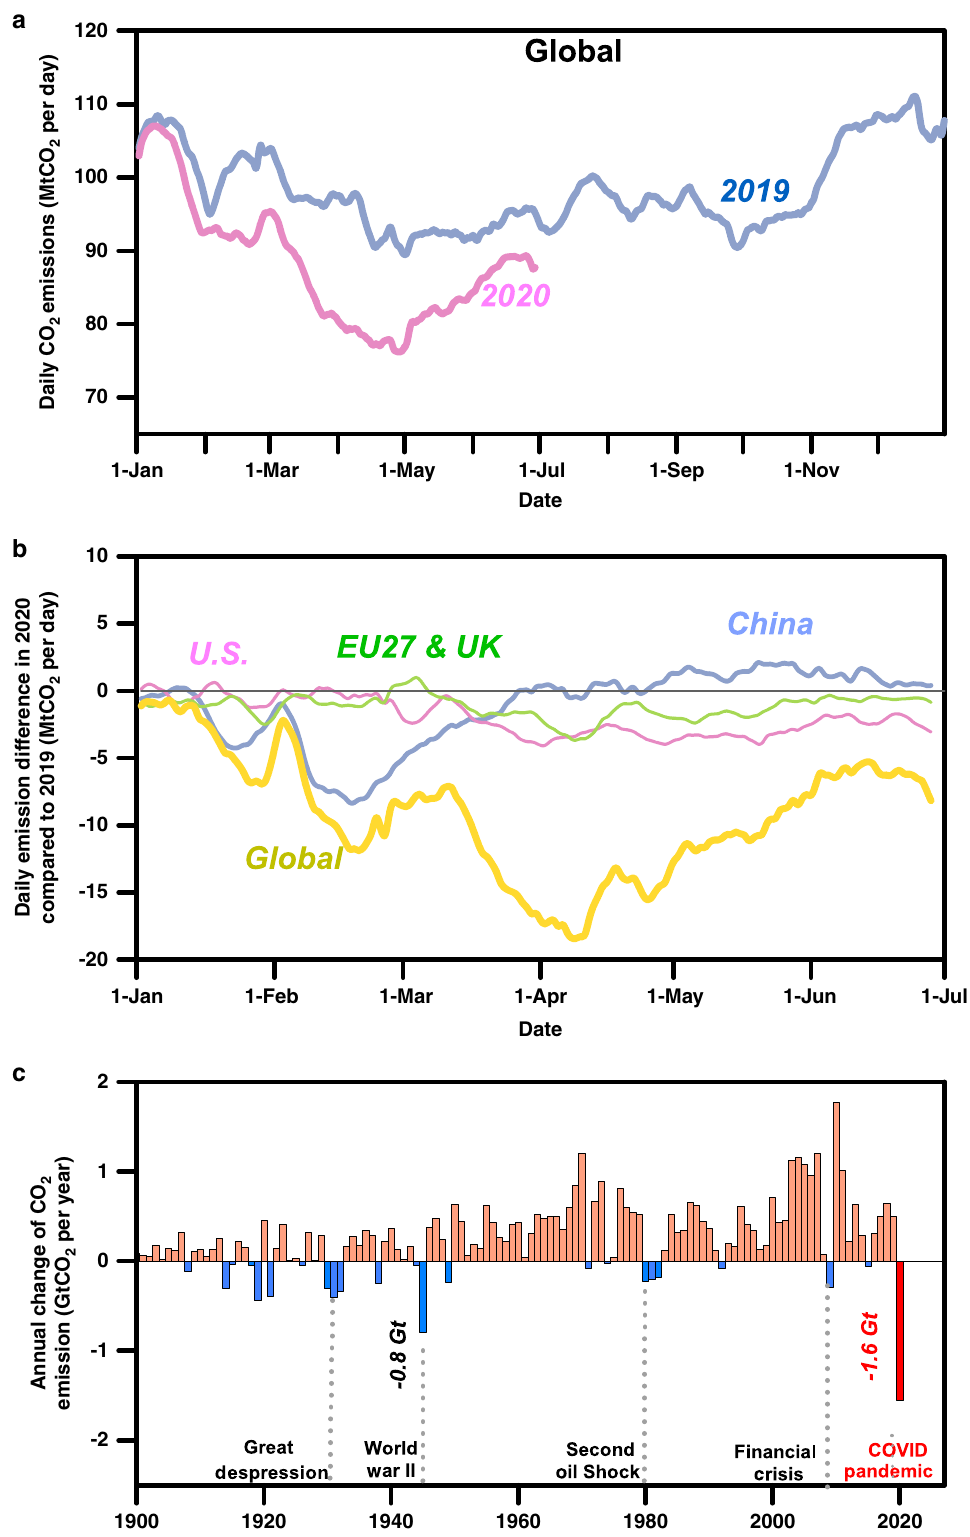
Fig. 1 Effects of COVID-19 on global CO 2 emissions. a Daily CO 2 emissions in 2019 and 2020 (7-day running mean); b Global emissions aggregate different timing of effects in different regions (7-day running mean); c COVID-19 causes the largest annual decrease of CO 2 emission since